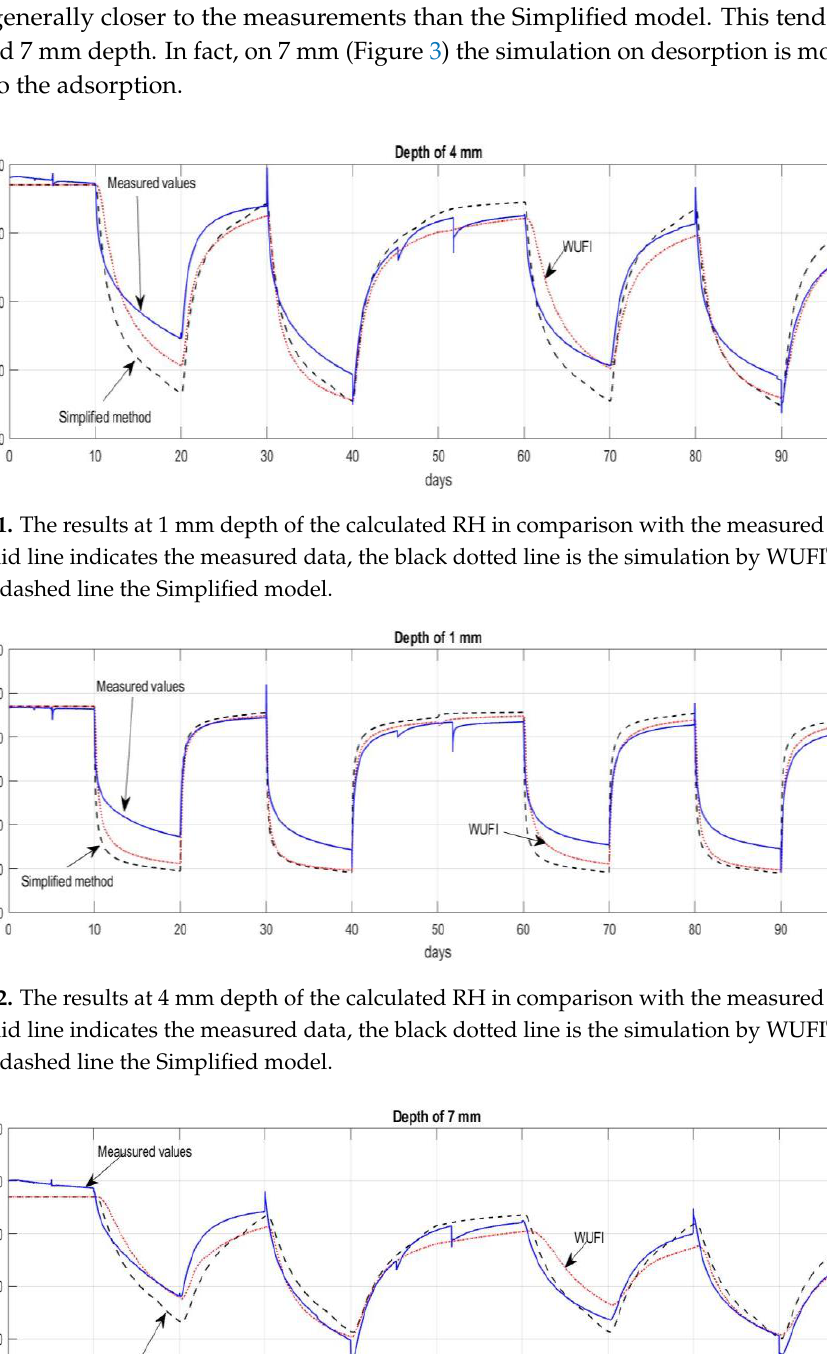
Figure 1. The results at 1 mm depth of the calculated RH in comparison with the measured data. The blue solid line indicates the measured data, the black dotted line is the simulation by WUFI ® Pro and the red dashed line the Simplified model .